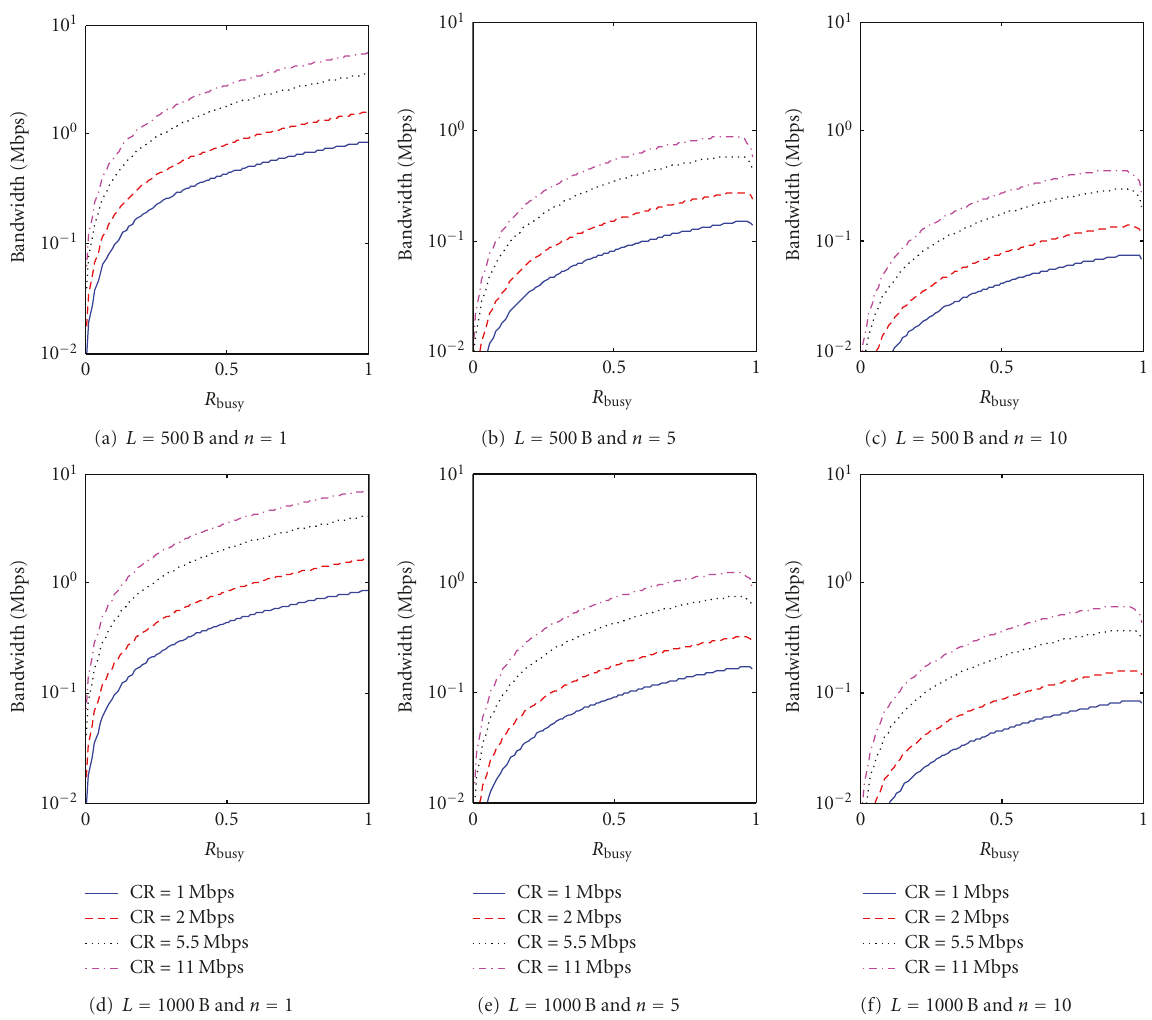
Figure 4: Numerical analysis results of bandwidth